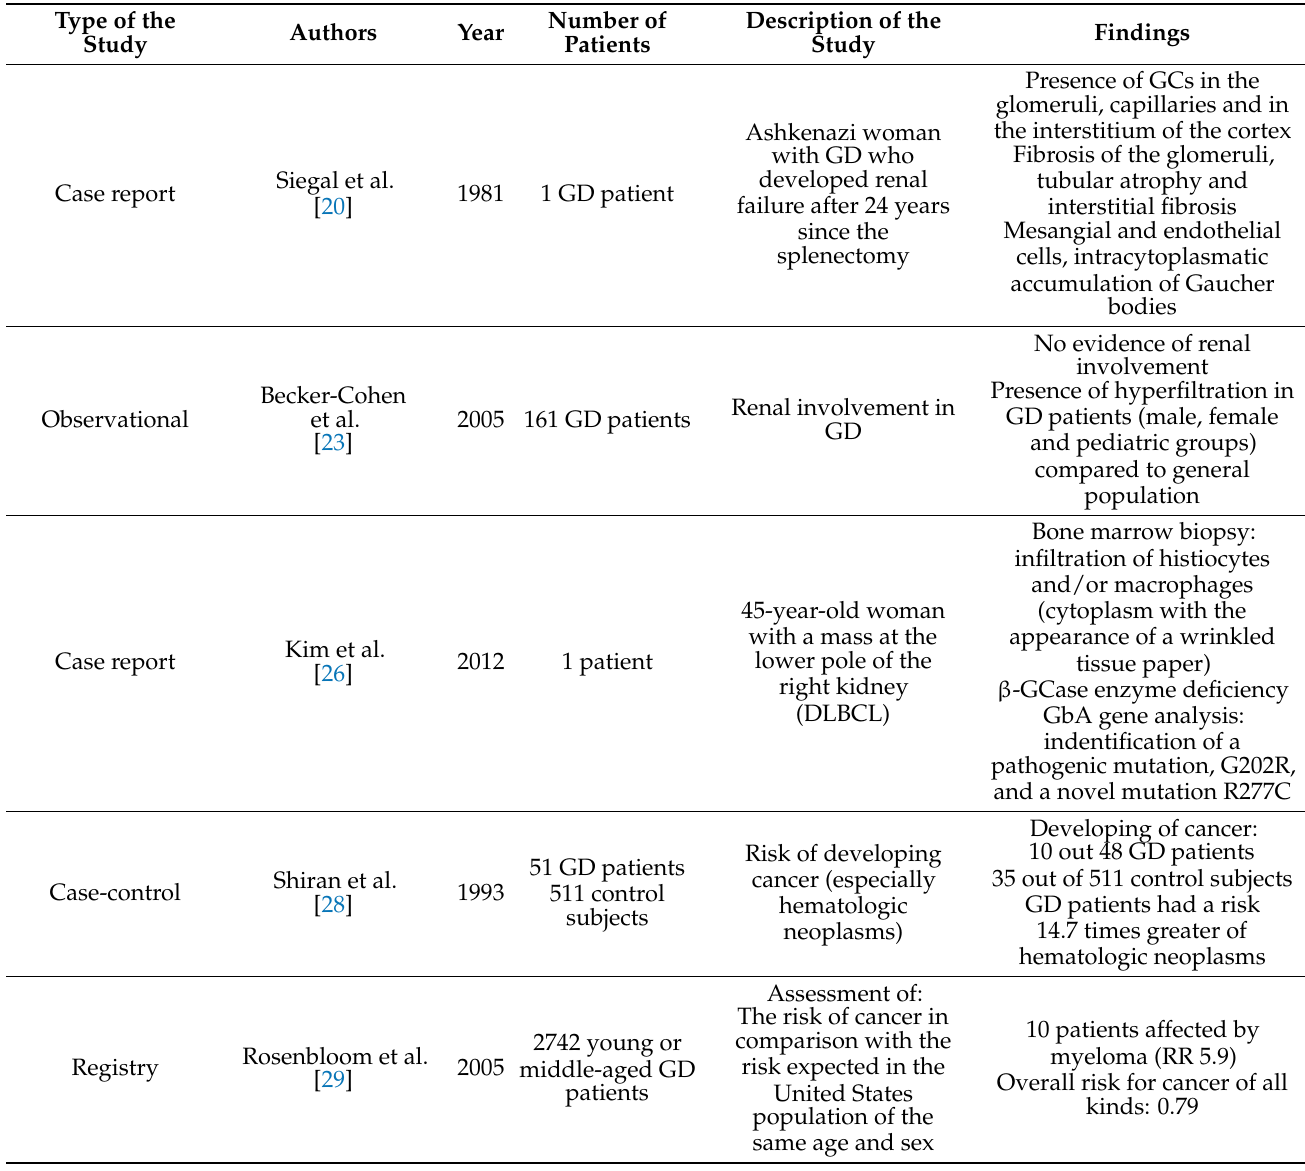
Table 2. GD manifestations and chronic kidney